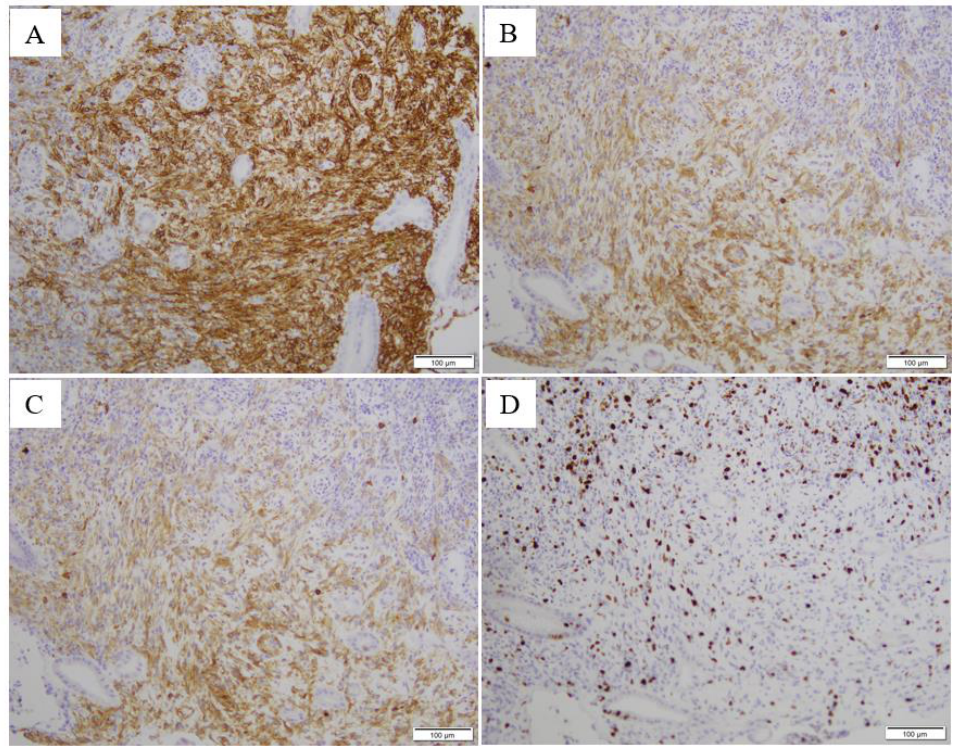
Figure 4. CD34 ( A ), CD117 ( B ), DOG1 ( C ), and Ki-67 ( D ) of the gastroscopic biopsy after admission. The preoperative diagnosis of GIST clinically depends on the abdomen CT, such as CT has found that tumours grow outside or between the cavity, with large diameter, unclear boundary, and leaf- shaped growth; large internal necrosis of tumour; and infiltration or metastasis of surrounding tissue. This indicates a malignant tumour. The final qualitative diagnosis depends on surgical pathology and immunohistochemistry.